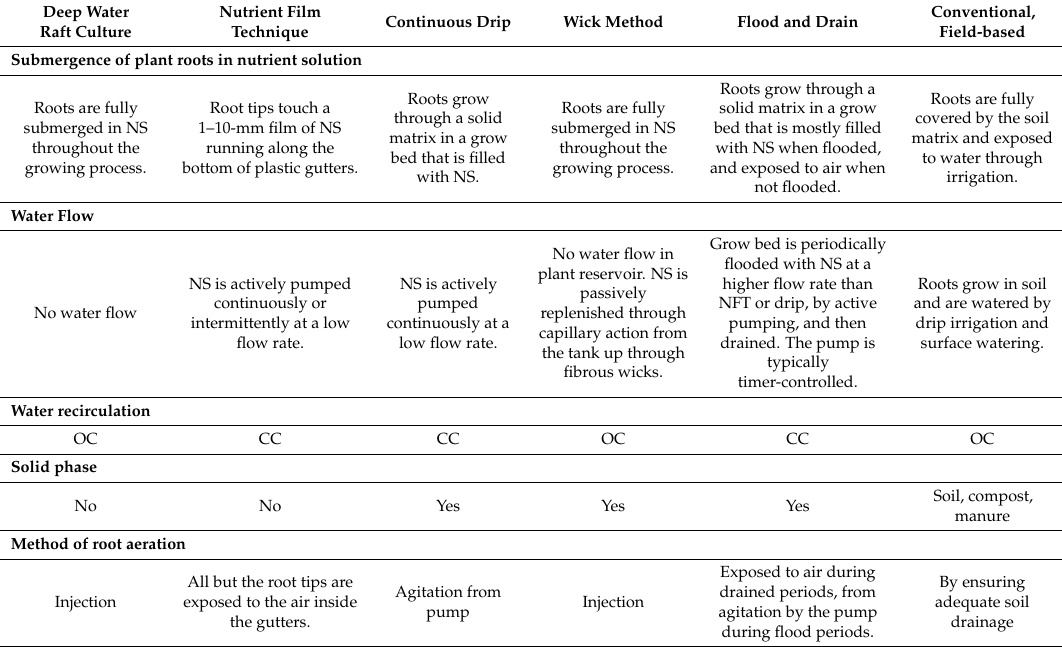
Table 1. Hydroponic leafy vegetable systems compared to conventional farming systems. Deep Water Raft